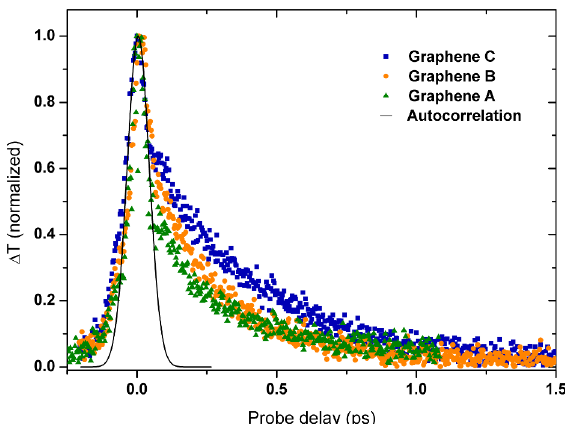
Figure 1. Measured di ff erential transmission, ∆ T , plotted as function of the probe delay for graphene samples A, B and C. ∆ T is normalized at 1 for each graphene sample. The solid line represents the autocorrelation of the pump and probe pulses (full width at half maximum of ∼